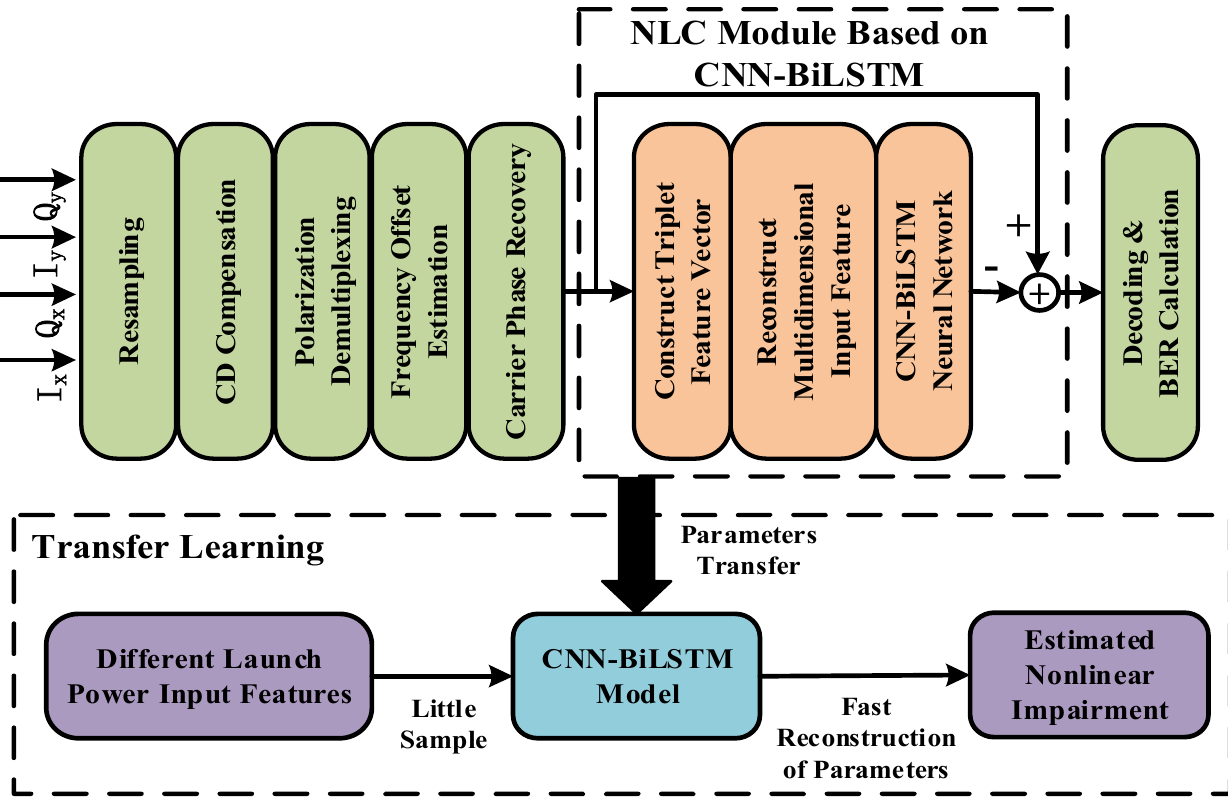
Figure 1. Schematic diagram of NLC scheme based on transfer learning-assisted CNN-BiLSTM .